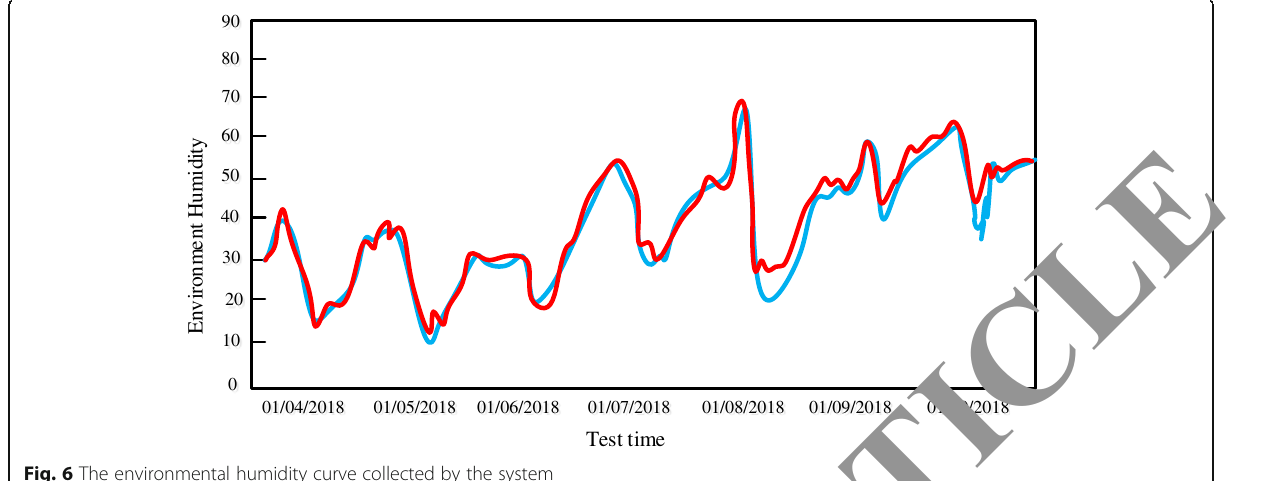
Fig. 6 The environmental humidity curve collected by the system